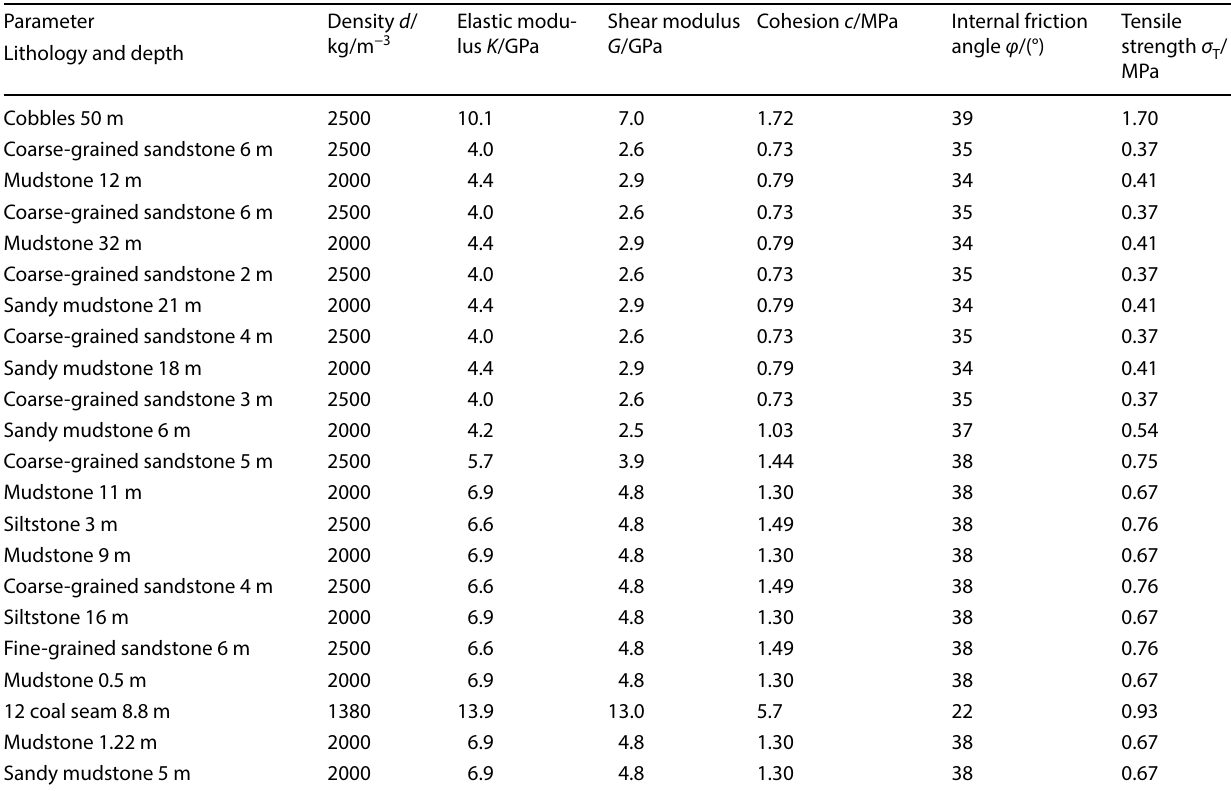
Table 1 Rock mass physico-mechanical parameters